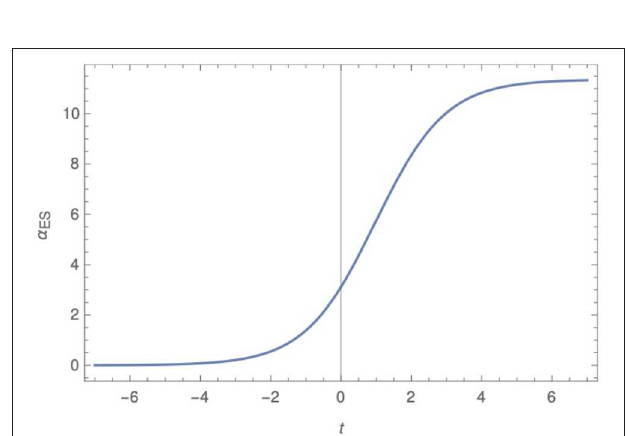
FIGURE 6 | α E S [ t ] as function of